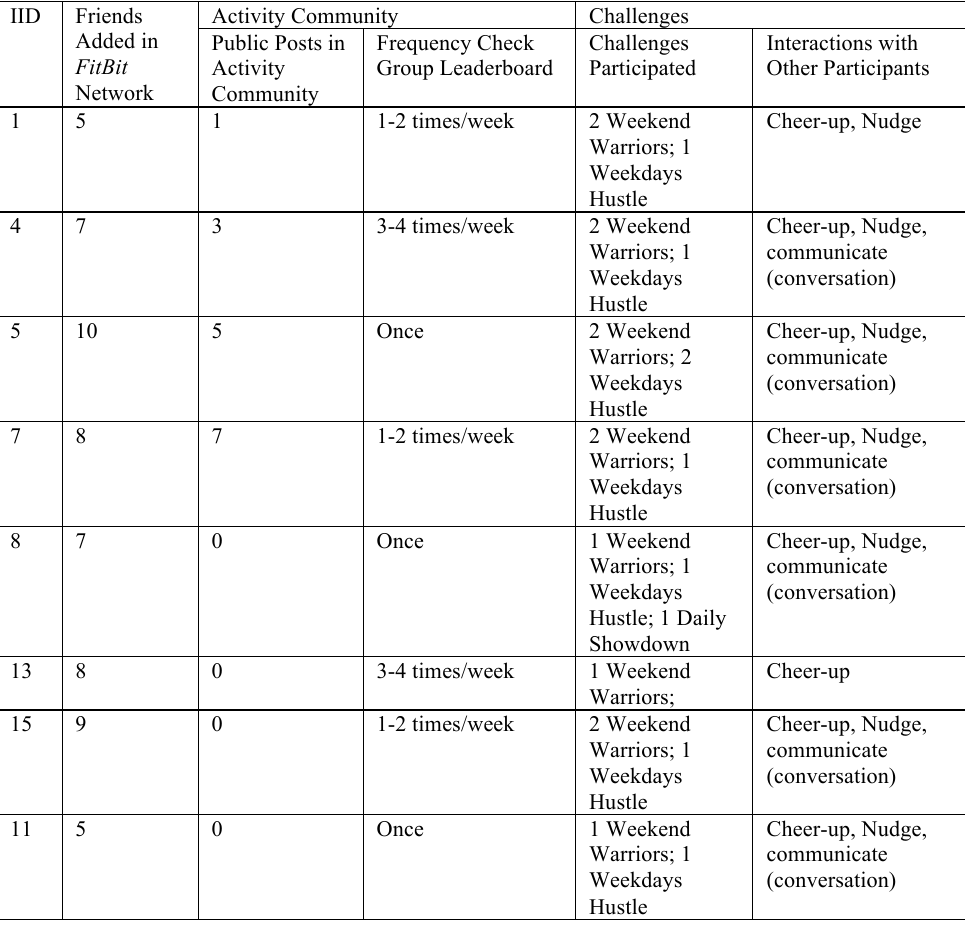
Table 2. Experimental Group Two: Social Community and Interaction Information during the Intervention